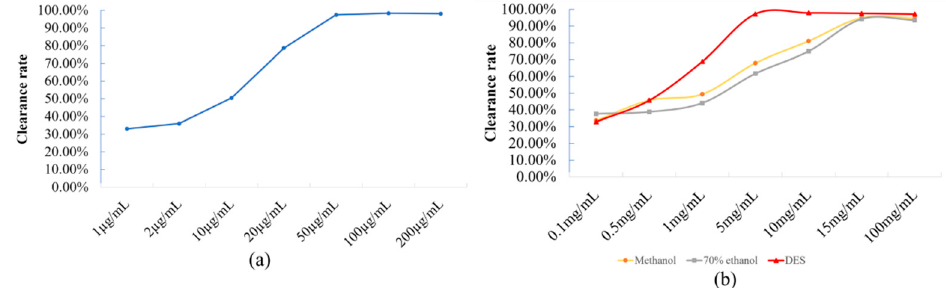
Figure 5. The DPPH radical scavenging activities of ( a ) the VC reference solution and ( b ) methanol, 70% ethanol and the DES solution.